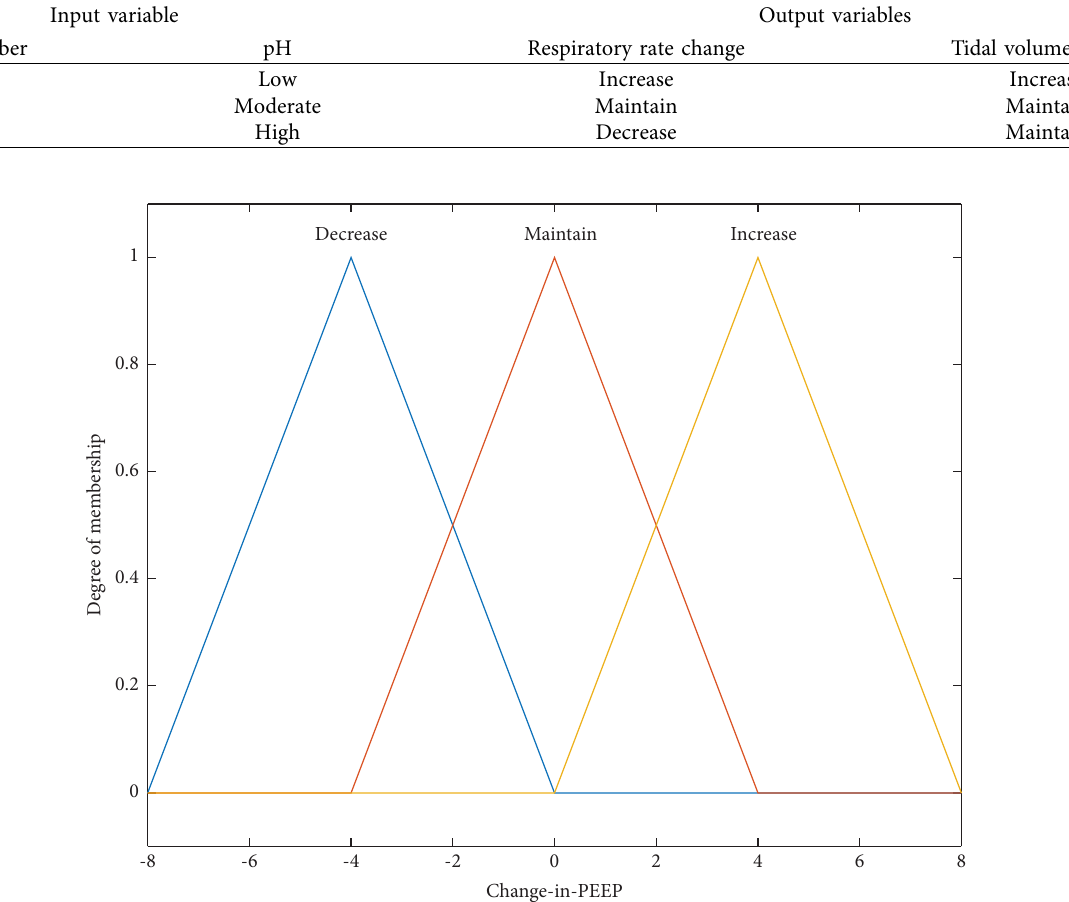
Figure 6: Membership function for change in PEEP